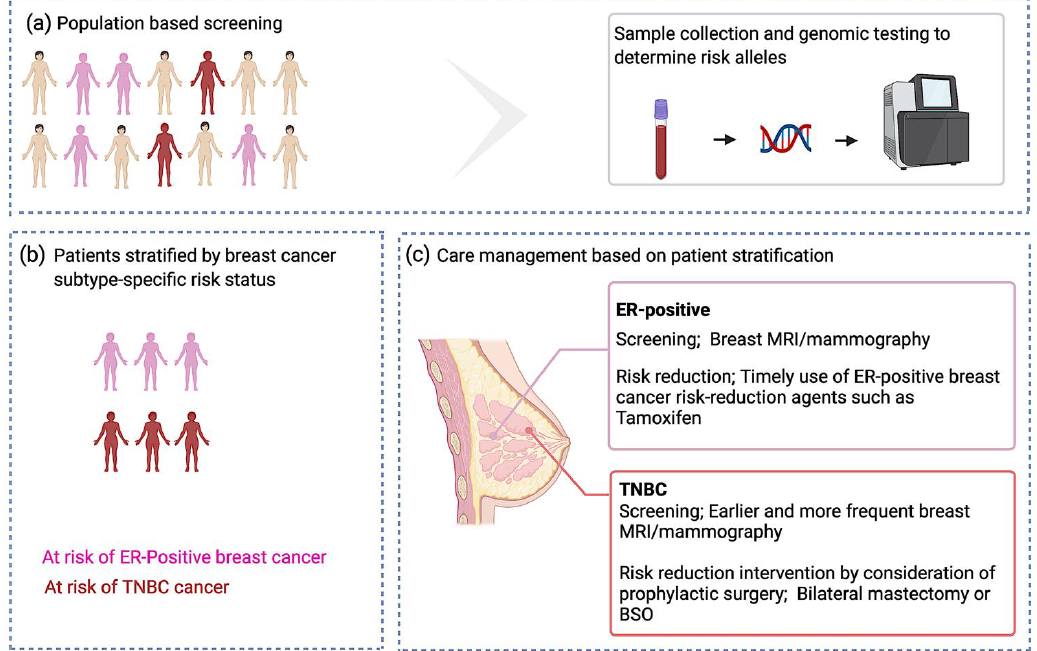
Figure 4. Breast cancer subtype-specific screening and preventive approaches proposal. ( a ) Genetic testing to identify risk alleles; ( b ) stratification of at-risk individuals based on the presence of breast cancer subtype-specific risk alleles; and ( c ) Subtype-specific care management.